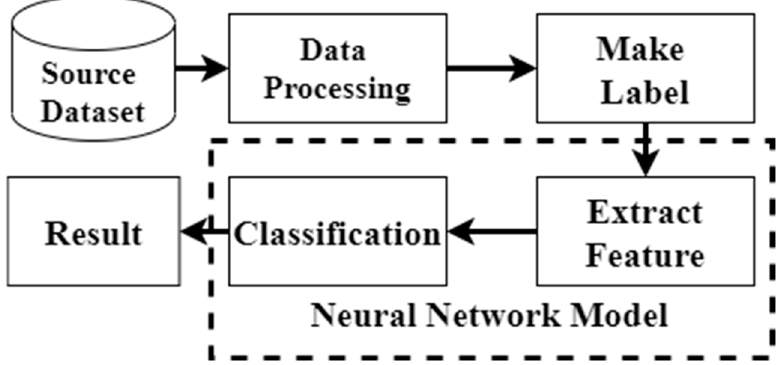
Figure 2. General vulnerability detection process.